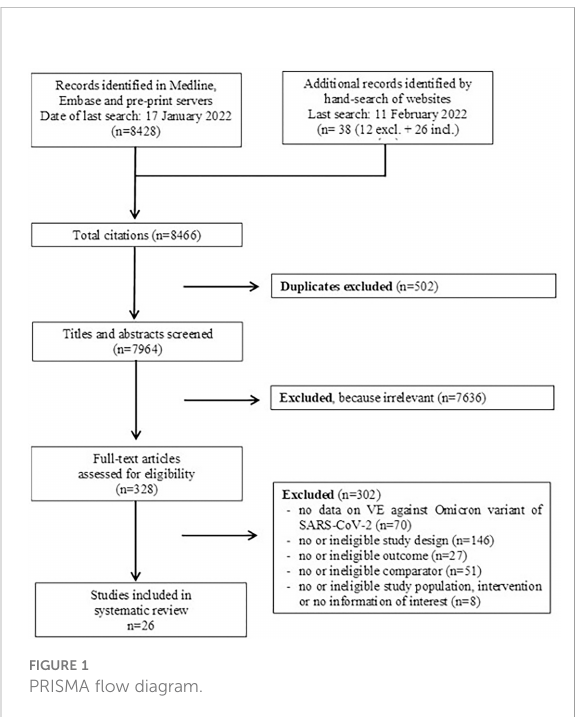
FIGURE 1 PRISMA fl ow